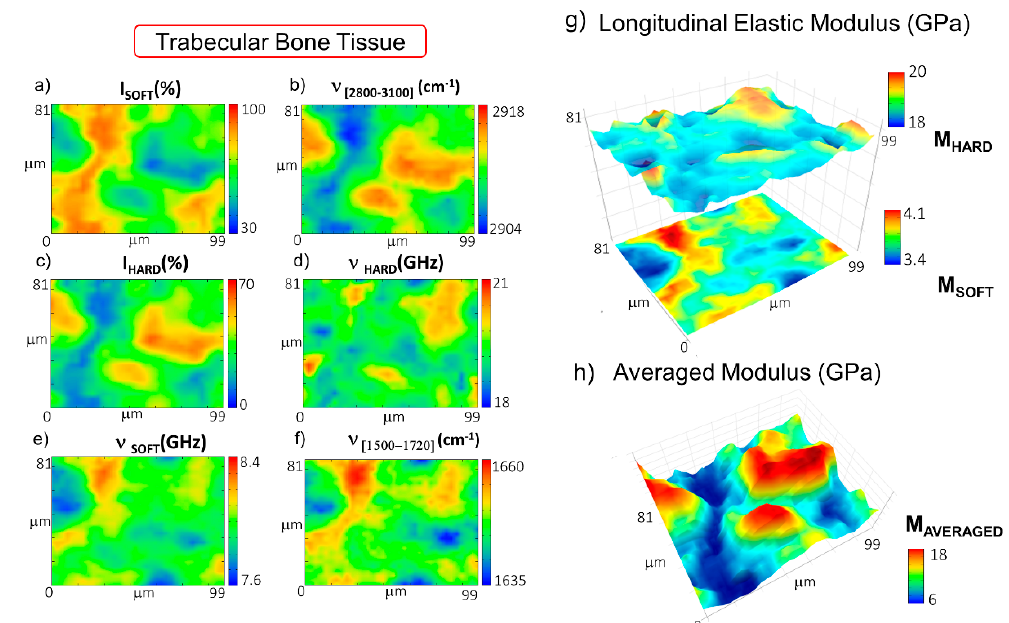
Figure 3. Maps of the distribution in the trabecular bone of ( a ) the relative percentage of P SOFT component; ( b ) the first spectral moment of CH 2 -CH 3 signal at 2800–3100 cm − 1 ; ( c ) the relative percentage of the P HARD component; the frequency shifts of ( d ) the P HARD and ( e ) the P SOFT components; ( f ) the first spectral moment of the heme-amide I signal at 1500–1720 cm − 1 ; ( g ) stacked surface plots of the longitudinal elastic moduli of the soft and hard components (M SOFT and M HARD ); ( h ) surface plot of the average longitudinal elastic modulus (M AVERAGED ).